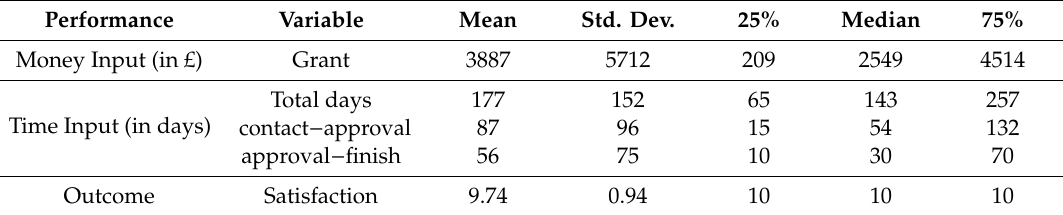
Table 1. Descriptive statistics of performance